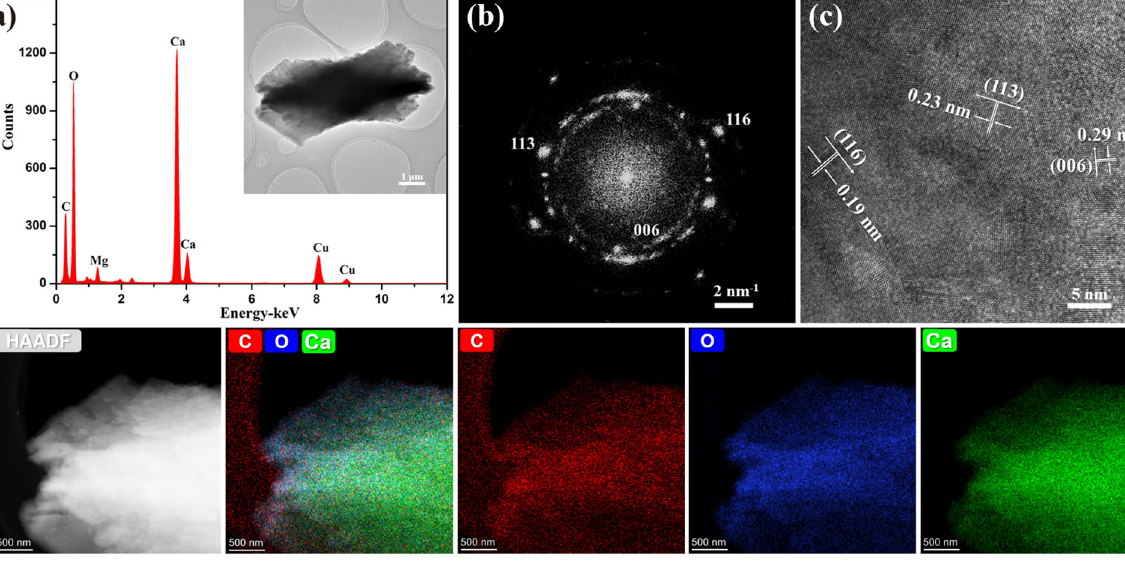
Fig. 5 TEM and EDS images of precipitates on the Q235 coupon after 14 days. a TEM and EDS images of a mineral particle from the Q235 coupon surface; b SAED pattern; c high-resolution transmission electron microscopy (HRTEM) analyses. The elemental maps show that C, O, and Ca were evenly distributed on the particle surface.